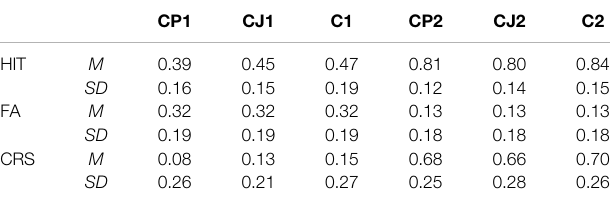
( Table 4 ). In ANOVA results for the CRS of CP, CJ, and C conditions, the main effect of time was signi fi cant [ F (1, 29) (cid:1) 277.47, p < 0.001, η p2 (cid:1) 0.91], while the main effect of condition [Greenhouse-Geisser corrected: F (1.645, 47.716) (cid:1) 2.06, p (cid:1)